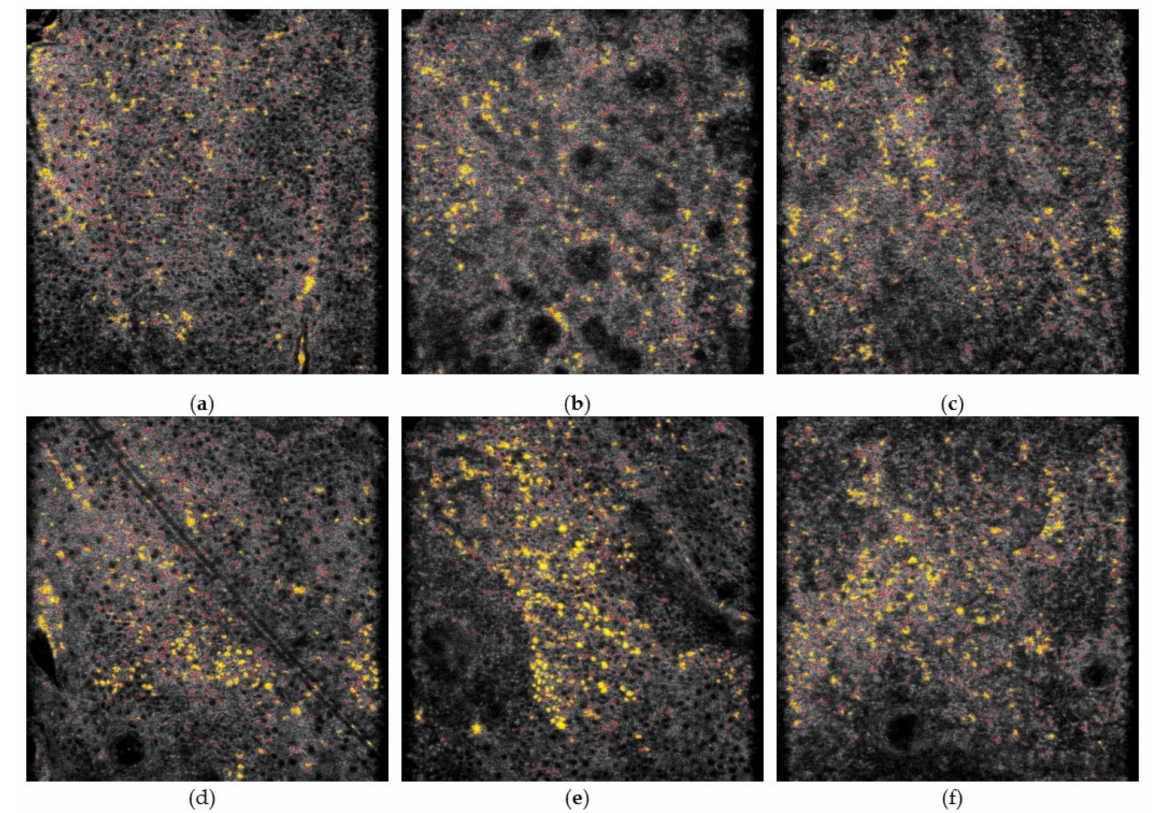
Figure 8. Comparison of melanin appearance between the representative lesion and perilesional skin images in different skin layers displayed by the CADe system. ( a – f ) are the perilesional skin images and the lesion images in the stratum spinosum, dermal–epidermal junction (DEJ), and papillary dermis, respectively. The field of view is 475 × 476 µ